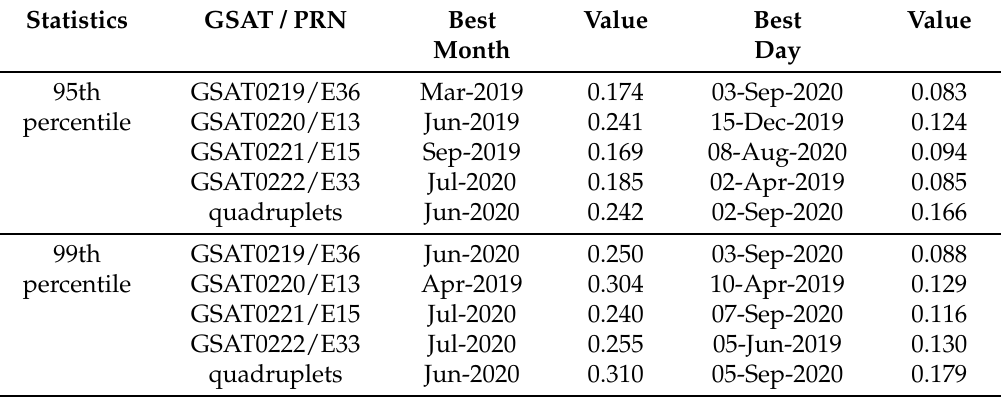
Table 4. Signal in Space Error (SISE) global average best month and best day [Unit: